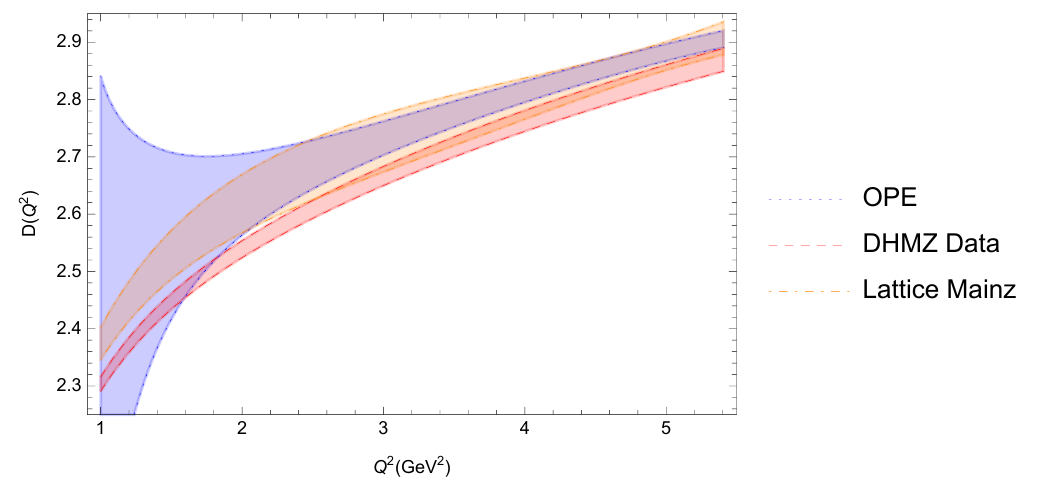
Figure 17 . Same plot as figure 15 but including the nonperturbative contribution in eq.